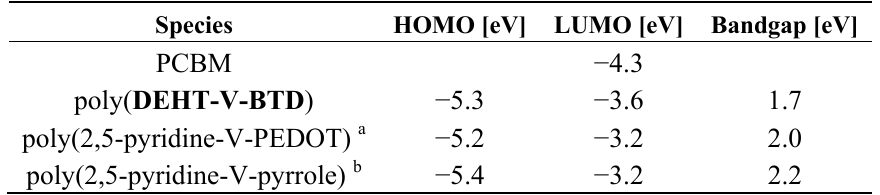
Table 2. Highest Occupied Molecular Orbital (HOMO), Lowest Unoccupied Molecular Orbital (LUMO), and bandgap energies of poly( DEHT-V-BTD ), in comparison with other D-A-D vinylene-linked polymers and